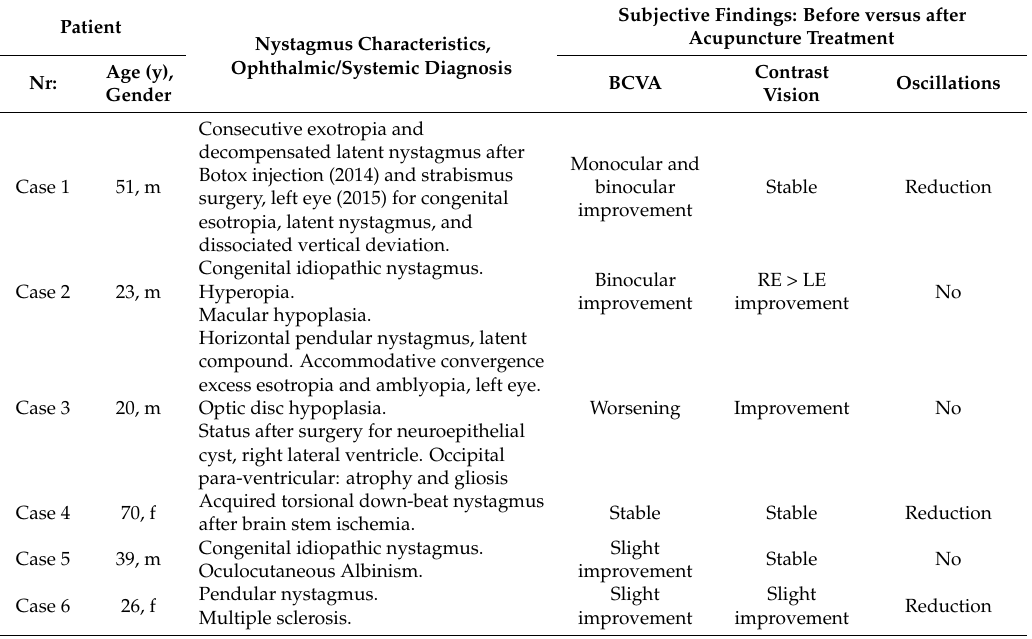
Table 2. Clinical characteristics of patients included in the